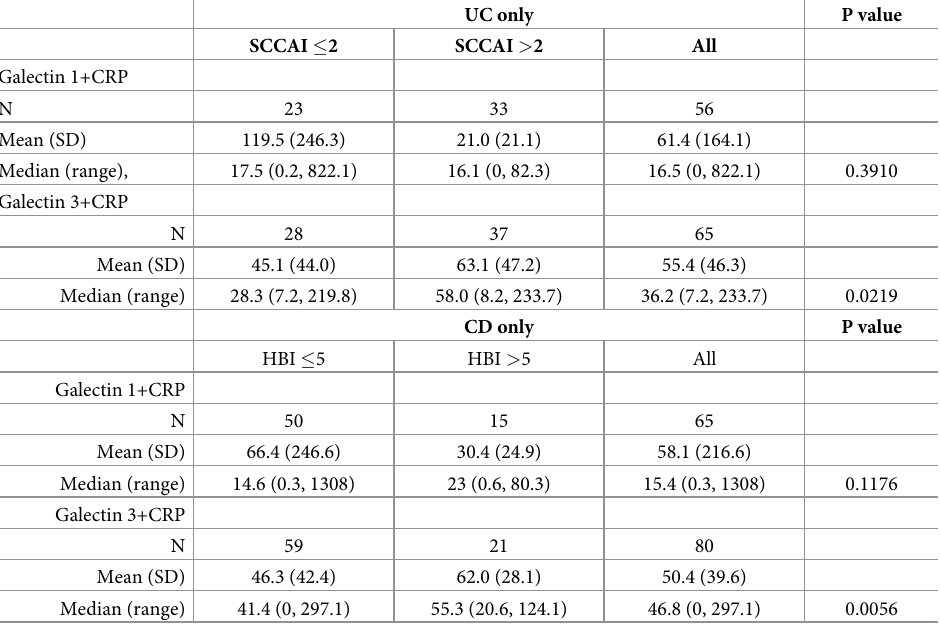
Table 6. ROC analysis of CRP alone or a combination of galectin 3 and CRP in active and inactive disease. UC only CD only UC + CD CRP 0.645 (0.540, 0.749) 0.642 (0.519, 0.765) 0.621 (0.542, 0.700) [N = 65] [N = 80] [N = 145] Galectin 3+CRP 0.667 (0.529, 0.805) 0.705 (0.579, 0.830) 0.668 (0.579, 0.756) [N = 65] [N = 80] [N = 145] Galectin 3+CRP ( < = 0.637 (0.517, 0.756) [N65] 0.698 (0.580, 0.816) [80] 0.667 (0.588, 0.746) [145] / > 52) Galectin 1+CRP 0.432 (0.275, 0.589) [56] 0.634 (0.457, 0.811) [65] 0.517 (0.408, 0.625) [121] Galectin 1+CRP ( < / > = 0.488 (0.353, 0.624) [56] 0.623 (0.482, 0.765) [65] 0.541 (0.450, 0.633) [121] 17.9) Cut-off with highest correct % classification is 17.9 and 52 for galectin-1 and -3 respectively (for all IBD patients)– hence values above relate to ROC curve for ‘CRP + galectin1 > = 17.9’ versus ‘CRP > 5’ and CRP + galectin3 > = 52’ versus ‘CRP > 5’. The numerical value for the combination of serum CRP and galectin was obtained by simply combining the actual